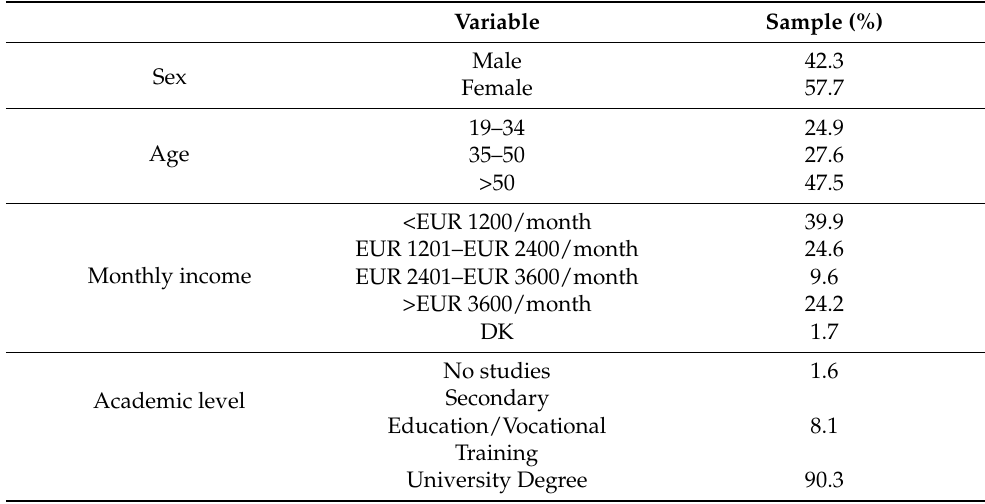
Table 1. Sociodemographic profile of the sample